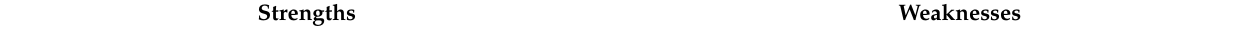
Table 1. Relevant SWOT factors identified that affect the DBH Sawit revenue-sharing scheme. Strengths